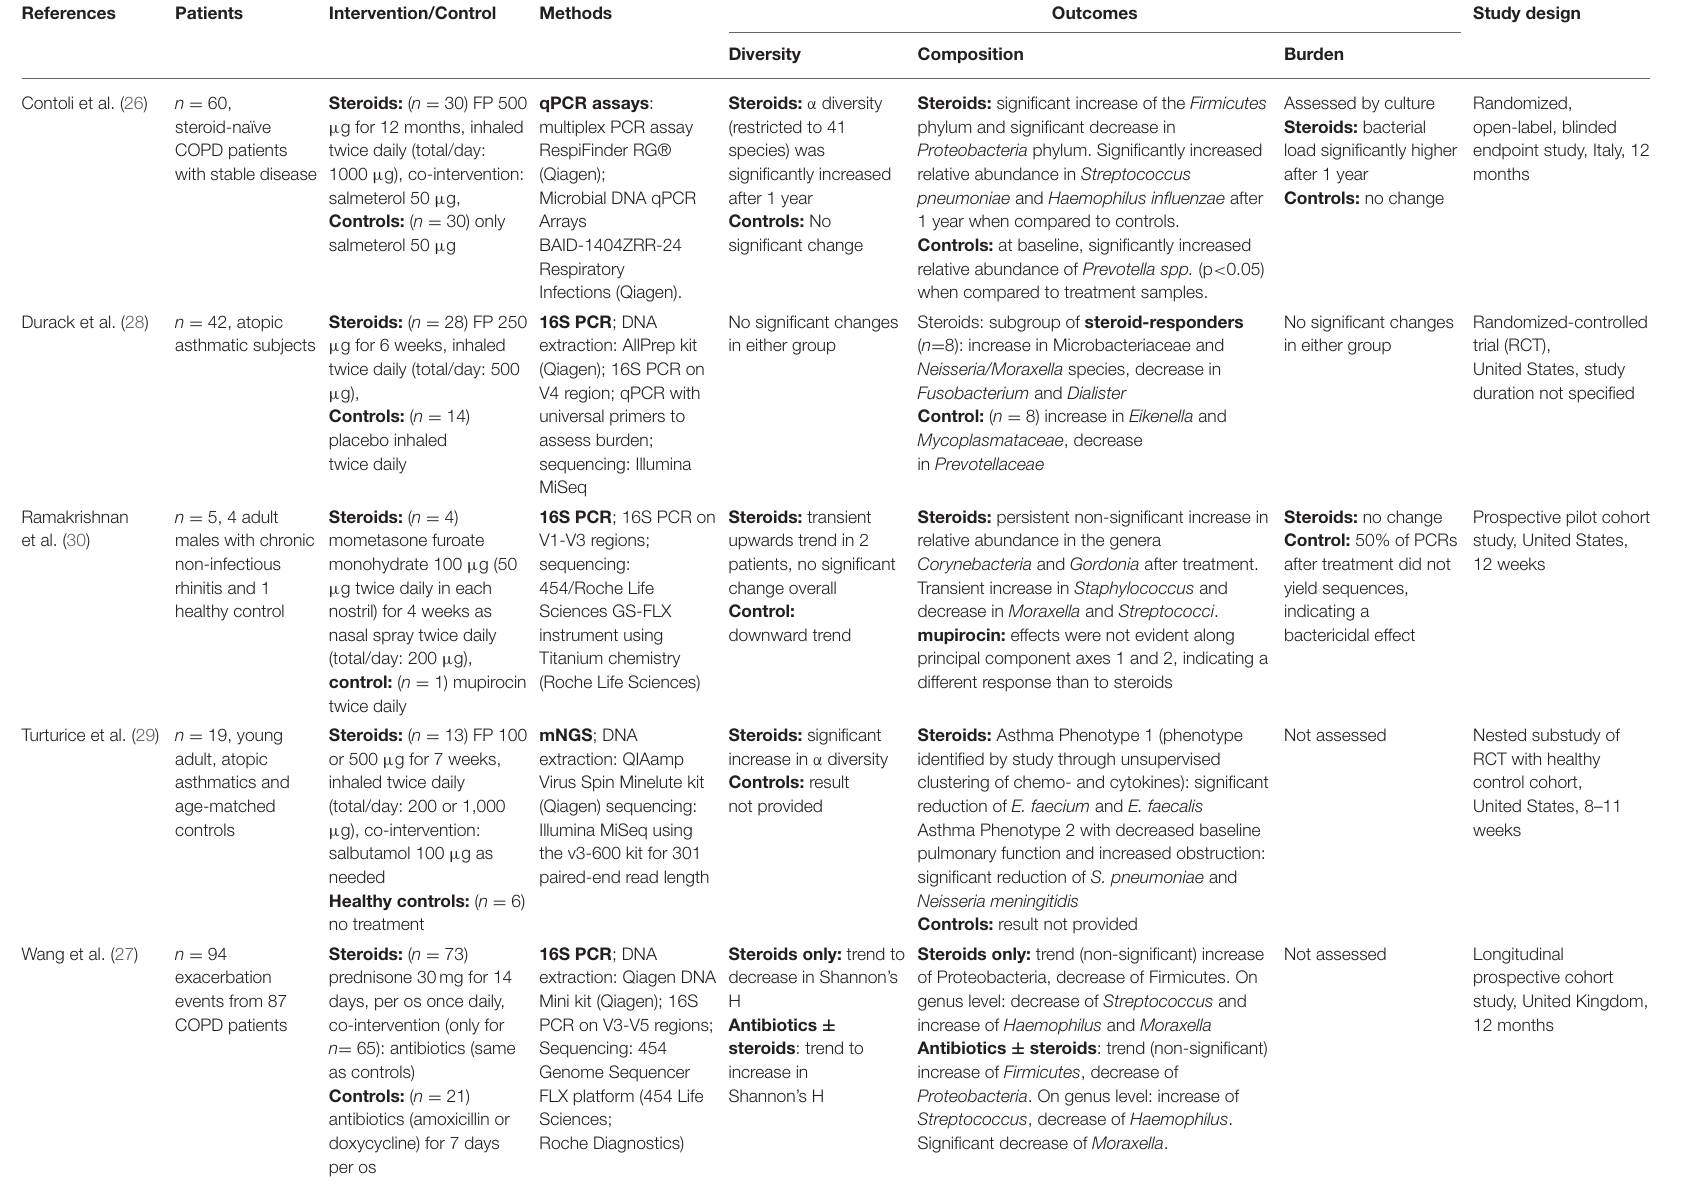
TABLE 1 | Summary of included studies and of reported microbiota